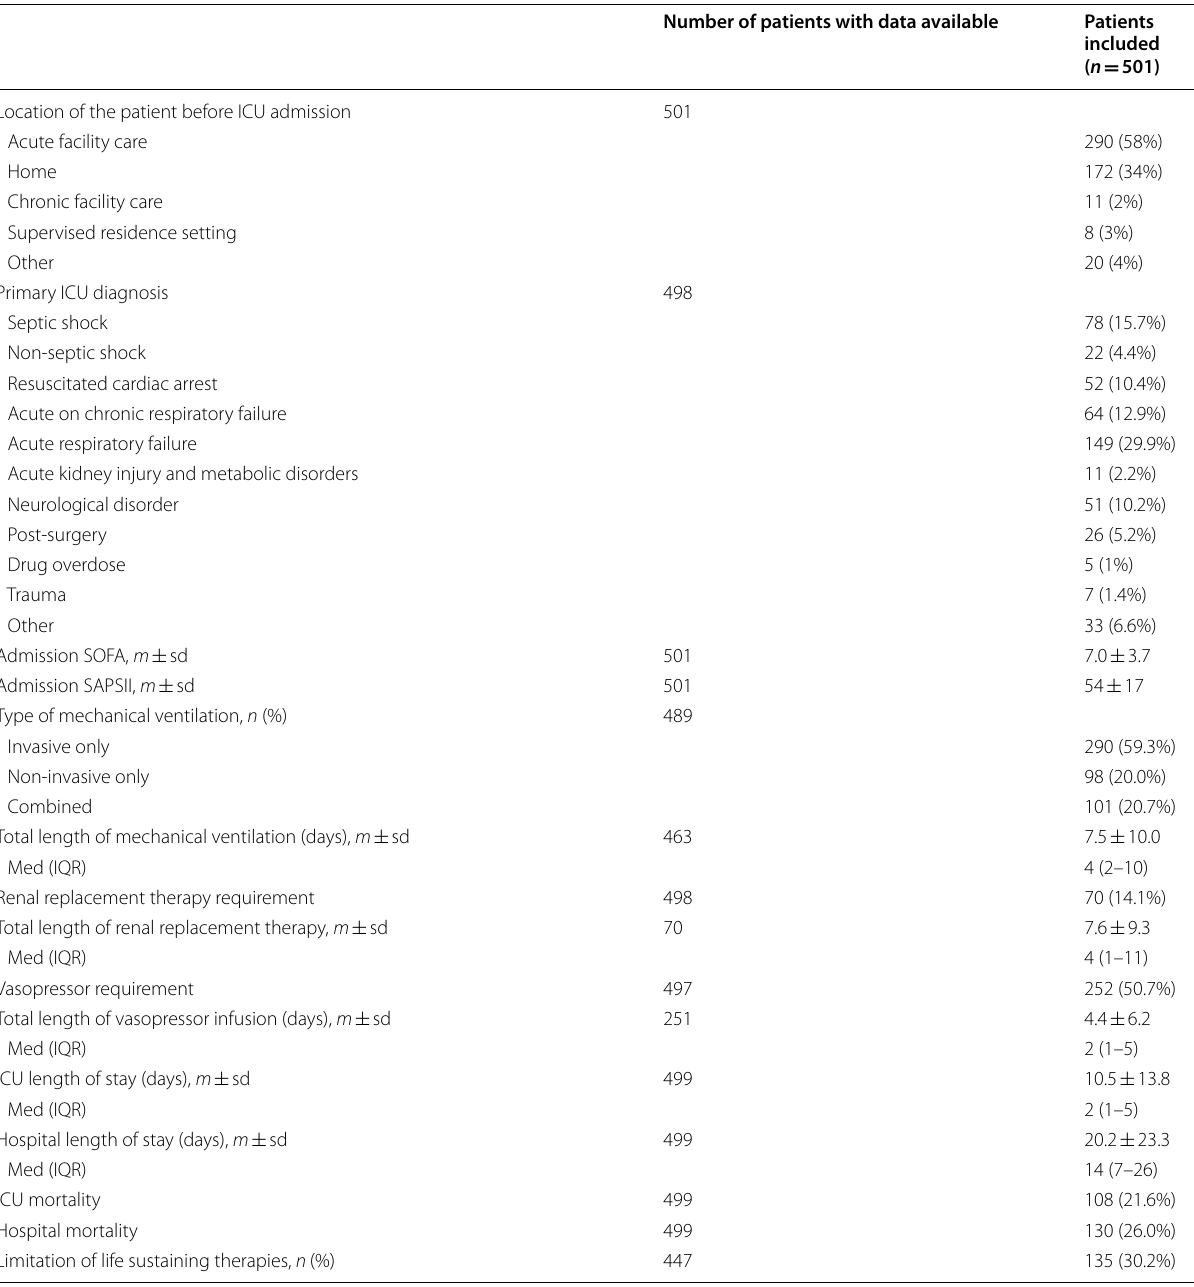
Table 2 ICU characteristics of the 501 patients included in the SENIOREA study